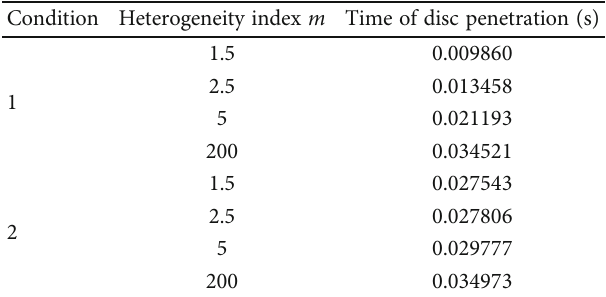
Figure 2: DDA simulations of Brazilian discs with di ff erent heterogeneity index m values: (a ; (a ) m = 1 : 5 ; (b ) m = 2 : 5 ; (c ) m = 5 ; (d ) m = 200 . 2 2 2 2 Table 1: Time for the cracks to penetrate the disc. Condition Heterogeneity index m Time of disc penetration